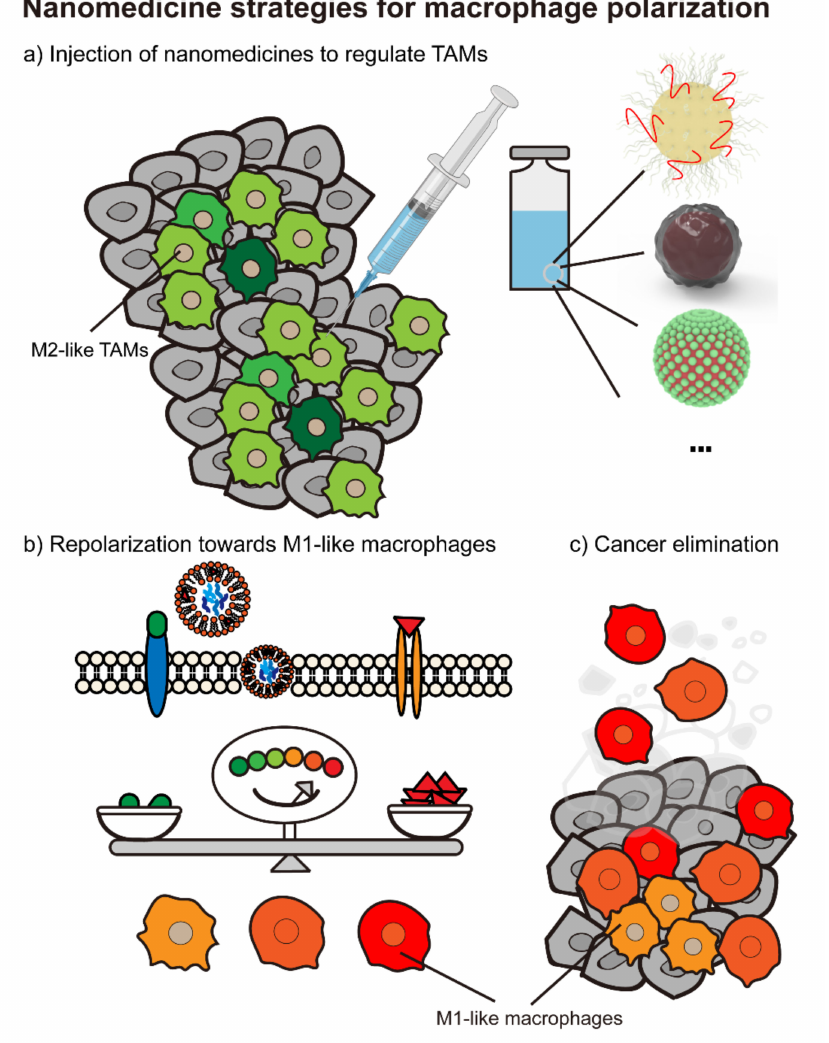
Figure 4. Nanomedicines targeting macrophage polarization. ( a ) There are plenty of nanoparticle strategies focusing on reprogramming M2-like tumor-associated macrophages into M1 poles, such as polymeric nanomaterials, lipid-based nanomedicines, inorganic nanoparticles and so on. ( b ) After the administration of nanocarriers, macrophages in the tumor microenvironment turn into a “friendly” subtype and ( c ) ultimately eliminate cancer cells together with other immune